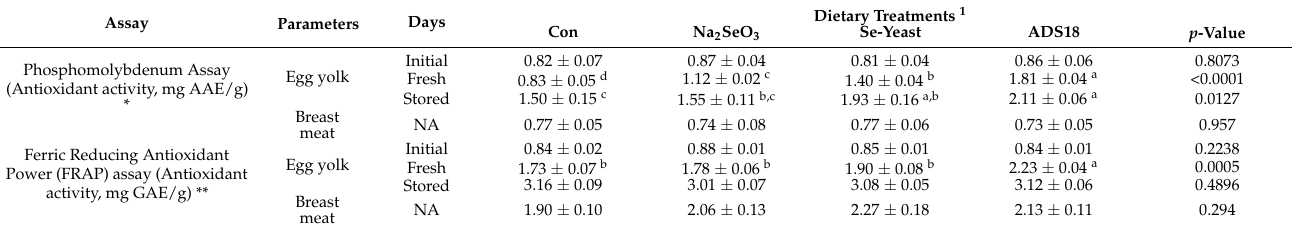
2 SeO 3 Se-Yeast ADS18 p -Value